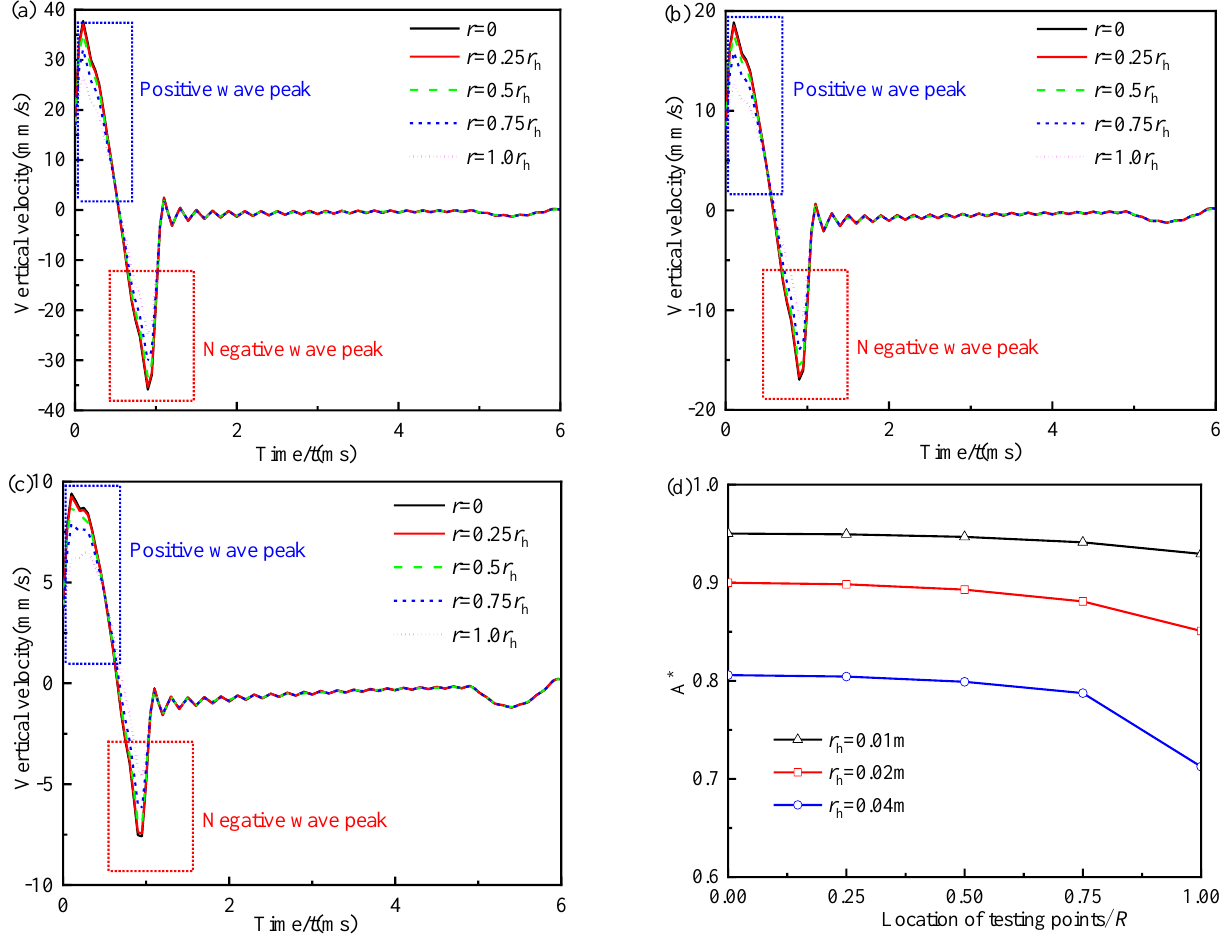
= 0.01 m; ( b ) r = 0.02 m; ( c ) r = 0.04 m; ( d ) h h h